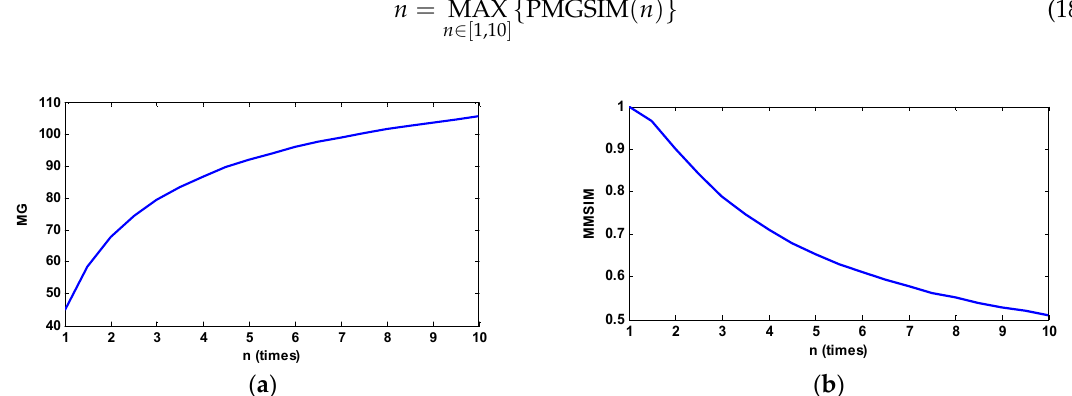
Figure 5. The relationships between the two measures and n . ( a ) MG of the enhanced image with different n values; ( b ) MMSIM of the enhanced image with different n values .